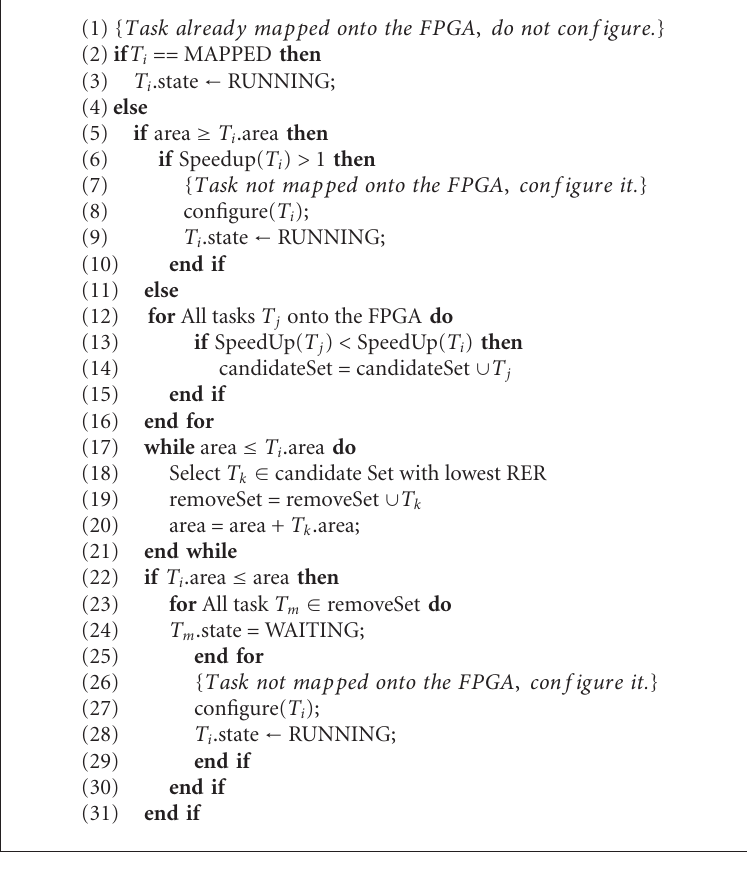
Algorithm 4: Pseudocode for the Reusability Based Heuristics (RBH) for the mapping on task T i .